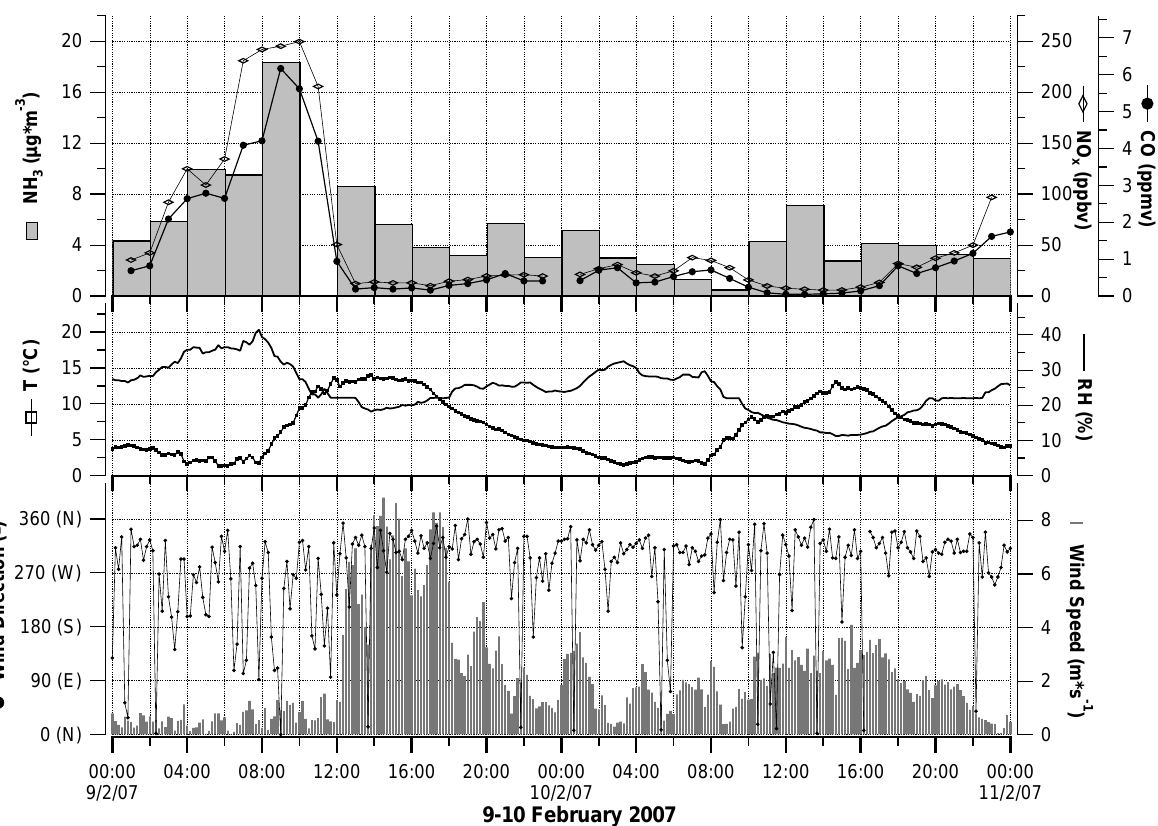
Fig. 3. Diurnal trends of NH 3 , NO x , CO, temperature ( T ), relative humidity (RH), wind speed and direction during the intensive winter